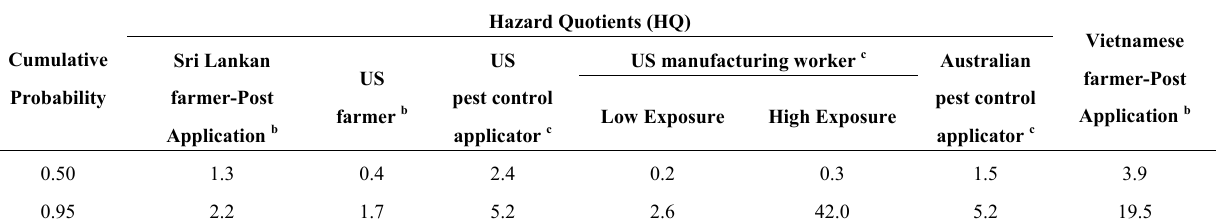
Table 6. Hazard Quotients (HQ) for occupationally exposed populations based on the ARfD a